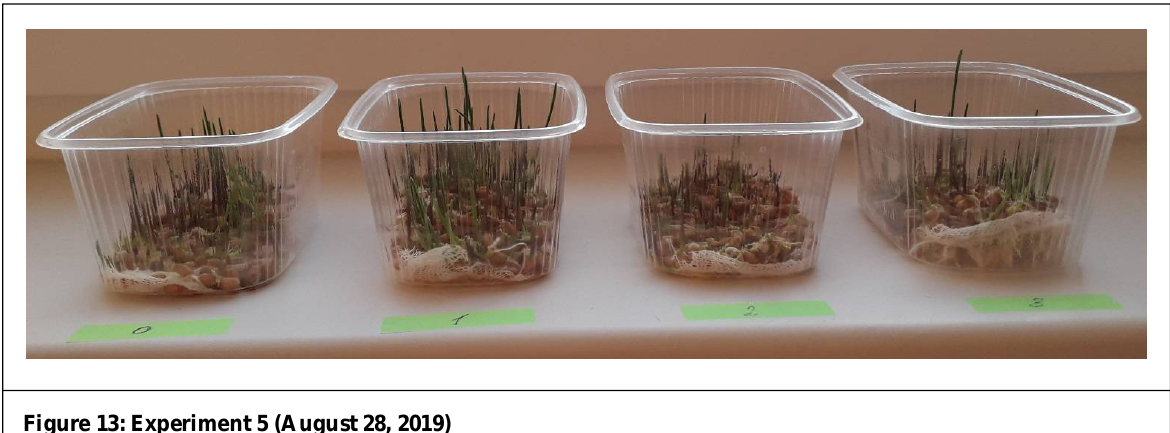
Figure 13: Experiment 5 (August 28, 2019) Sample 2 - the slowest growing.